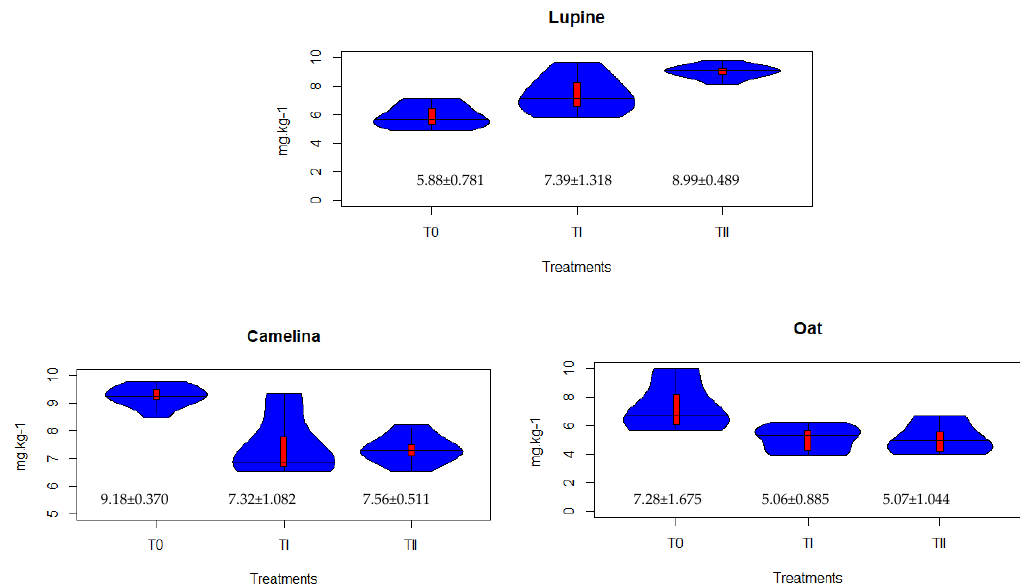
Figure 4. The nickel amounts in cultivated plants (lupine, camelina, oat) in dependence on treatments (T0, TI, TII). The values below the graphs are equal mean ± sd.